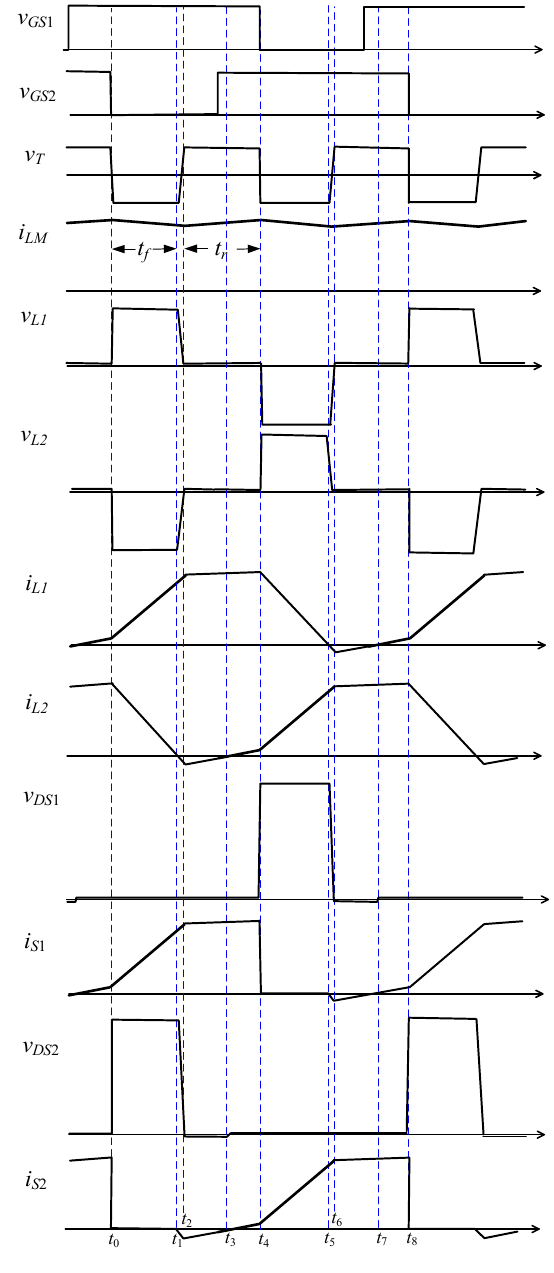
Figure 5. Conceptual waveforms.